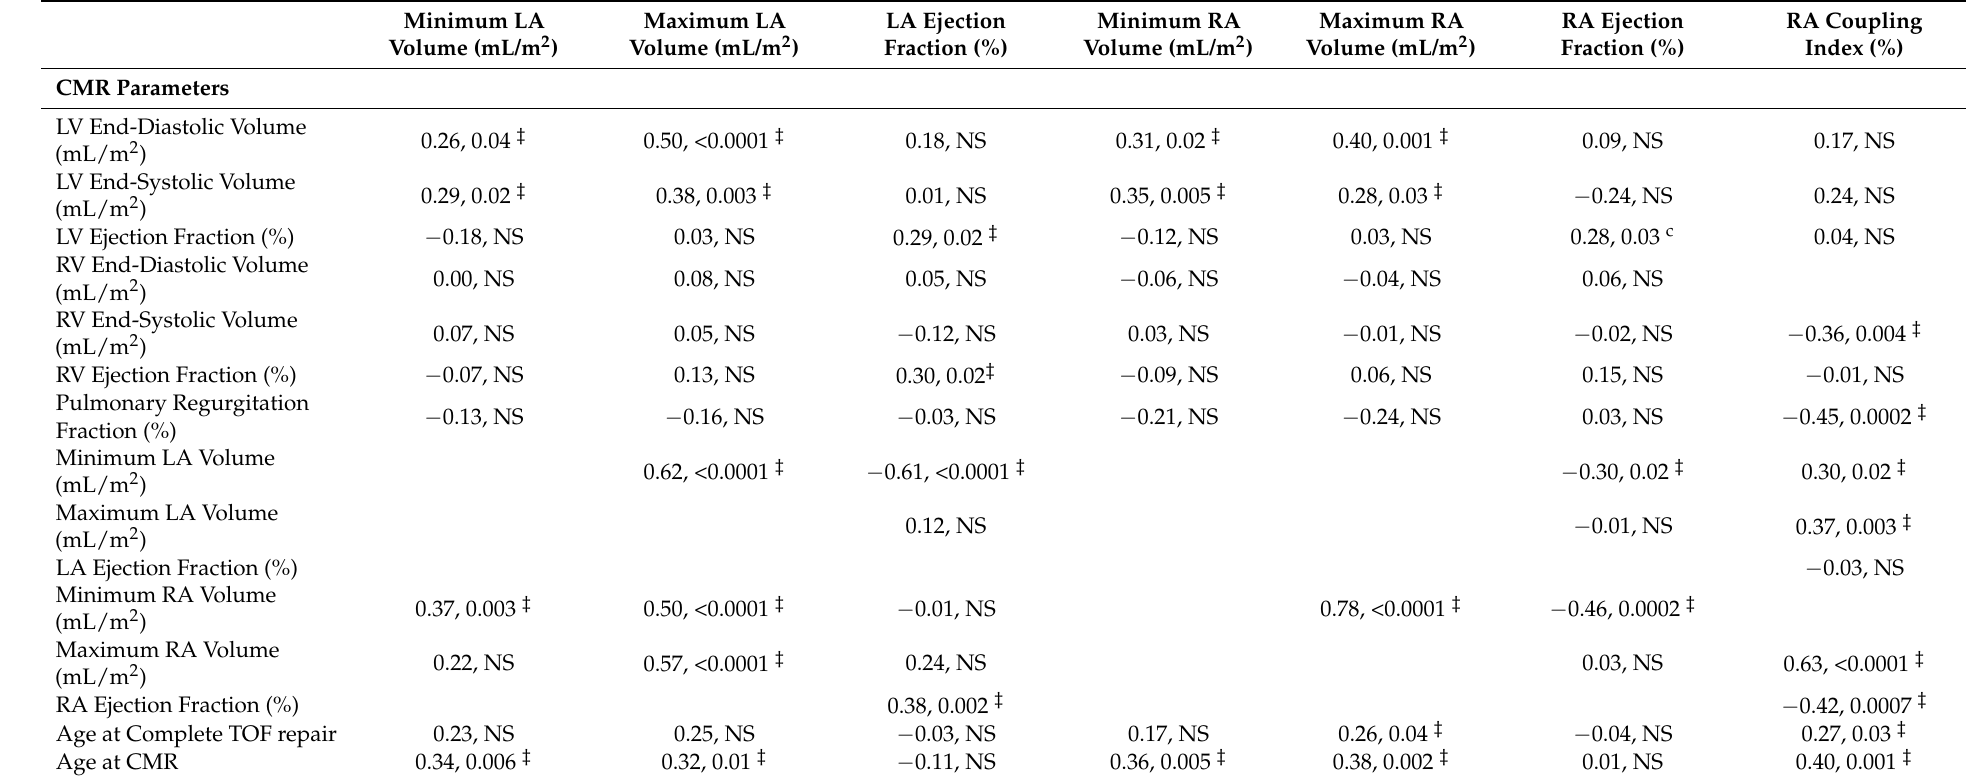
Table 2. Associations between atrial CMR measurements, additional CMR parameters, and age * ,† .